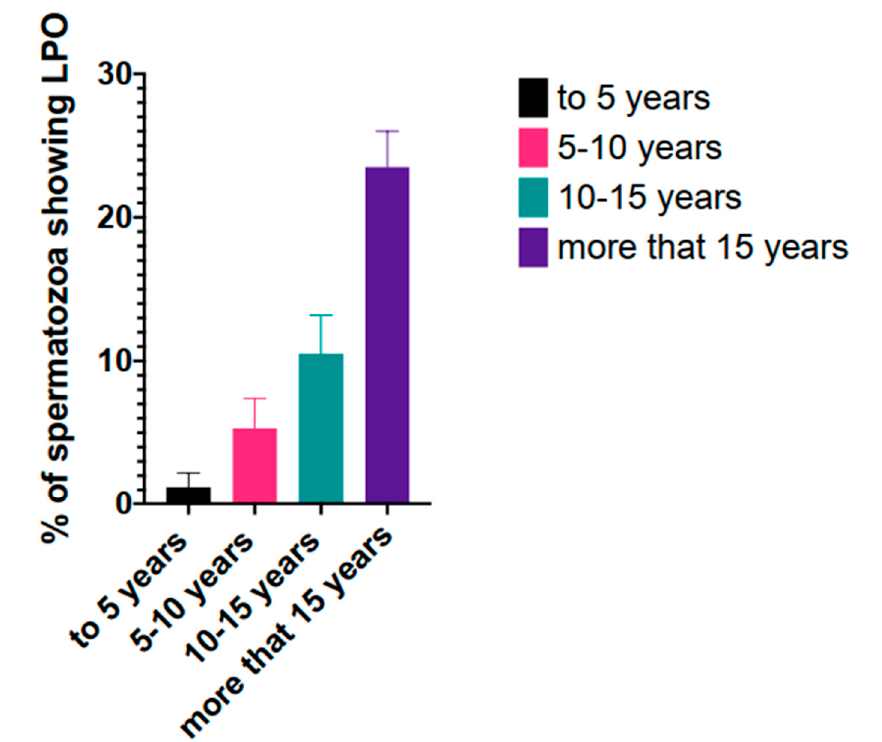
Figure 2. Effect of stallion age in the peroxidation of sperm membranes, semen was collected from stallions of different ages (to 5 years old, 5–10, 10–15 and more than 15 years old) and lipid peroxidation was assessed flow cytometrically after BODIPY 581/591 C11, as seen in the figure, lipid peroxidation increases with age.